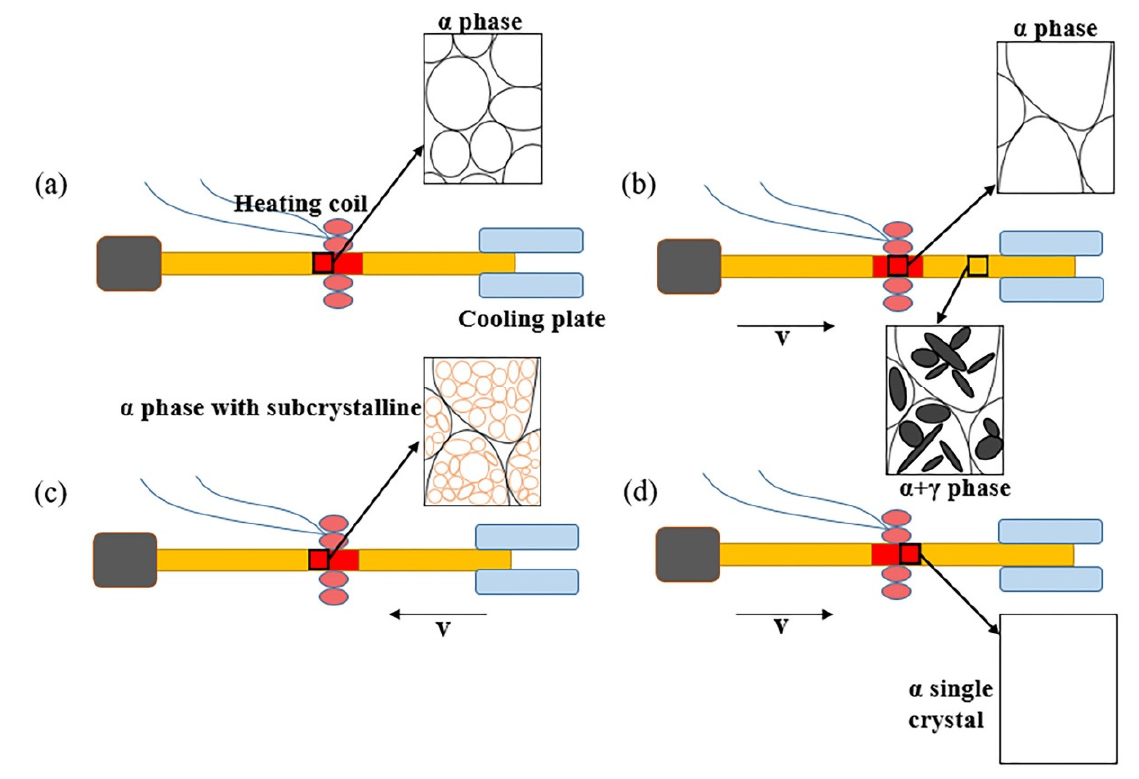
Figure 11. Schematic diagram of cyclic directional annealing: ( a ) the start of cyclic directional annealing; ( b ) after forward movement of the specimen; ( c ) after a cycle is completed; ( d ) after multiple cycles.